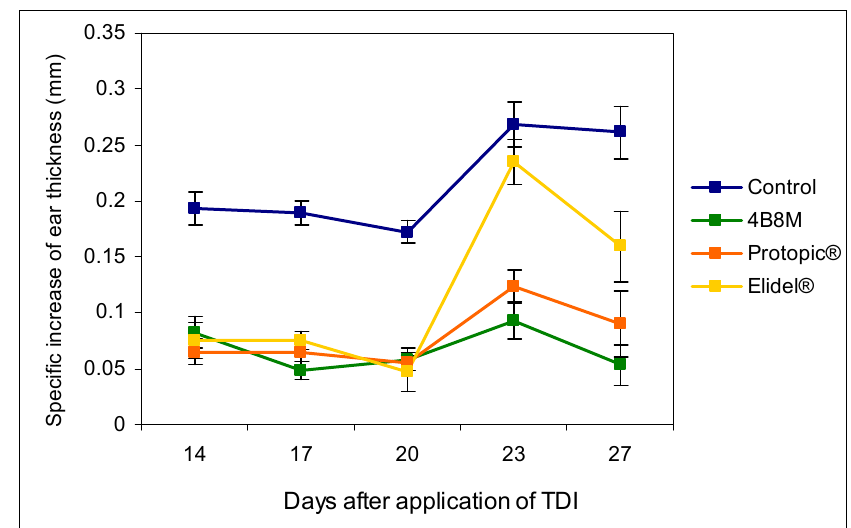
Figure 5. The effects of the 4B8M peptide and the reference drugs on the antigen-specific increase of the ear edema to toluene diisocyanate (TDI) (24-h measurement): mice were immunized with TDI over 3 consecutive days. After 14 days, the reaction was elicited with TDI on the ears. The procedure was repeated 5 times every 3 days. Twenty-four hours after each challenge with TDI, the ear thickness was measured. 4B8M was applied topically in 0.1% ointment on both sides of the ear 1 h following each challenge with TDI. The reference drugs were applied in a similar way. The antigen-specific increase of the ear edema (by subtracting BG values) as mean values ± SE for respective groups is presented. p < 0.05 for day 14: control vs. 4B8M, Protopic ® , and Elidel ® ; day 17: control vs. 4B8M, Protopic ® , and Elidel ® ; day 20: control vs. 4B8M, Protopic ® , and Elidel ® ; day 23: control vs. 4B8M, Protopic ® , and Elidel ® ; and day 27: control vs. 4B8M, Protopic ® , and Elidel ® (repeated measures ANOVA).